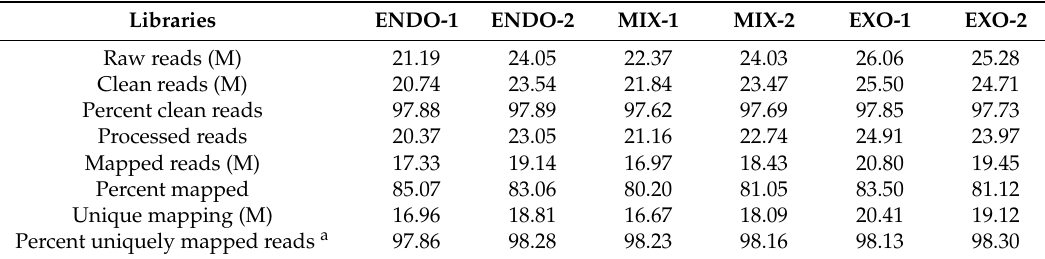
Table 1. Statistics for the filtering and mapping of reads.